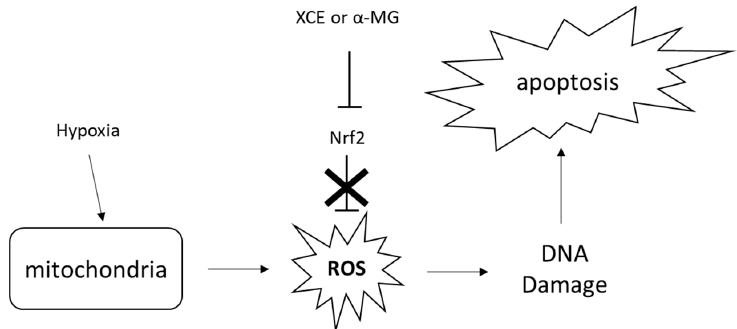
Figure 4. During hypoxia, mitochondrial reactive oxygen species (ROS) are induced exponentially. This could lead to DNA damage, which could induce apoptosis. Nrf2 is usually activated during this event to trigger an event that neutralizes ROS. Inhibition of NRF2 by XCE or α -MG disrupts ROS neutralization, promoting cell death by apoptosis.